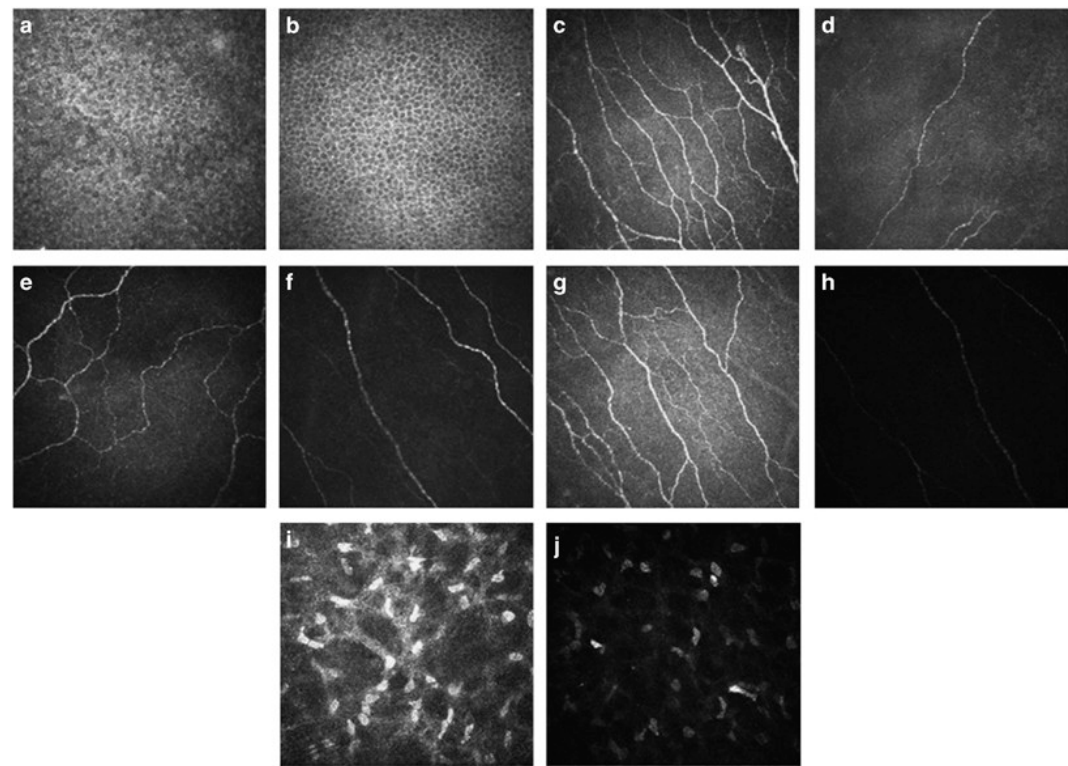
Figure 3. IVCM images of a patient with dry eye disease before and after six months of treatment with topical cyclosporine. Cell density of the intermediate epithelium of the cornea ( a , b ), number of nerve fibers of subbasal plexus in the cornea ( c , d ), nerve fiber tortuosity of subbasal plexus in the cornea ( e , f ), nerve fiber reflectivity of subbasal plexus in the cornea ( g , h ) and keratocyte activation in the cornea ( i , j ) are shown, the first picture always represents baseline and the second picture findings after six months therapy in the same patient. Reprinted from Iaccheri et al., 2017 [64].